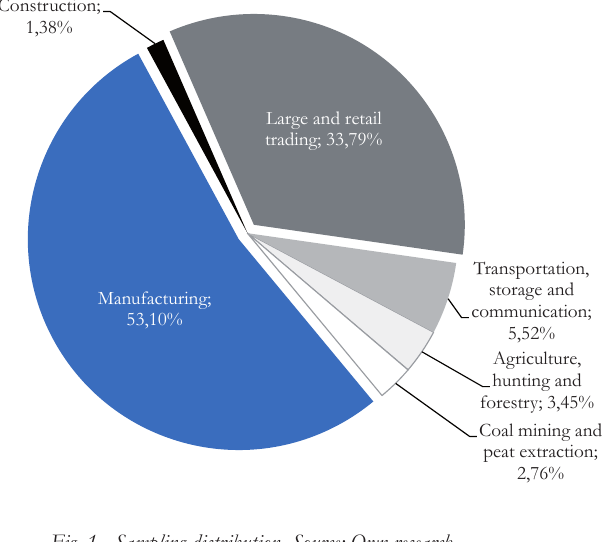
Fig. 1 - Sampling distribution. Source: Own